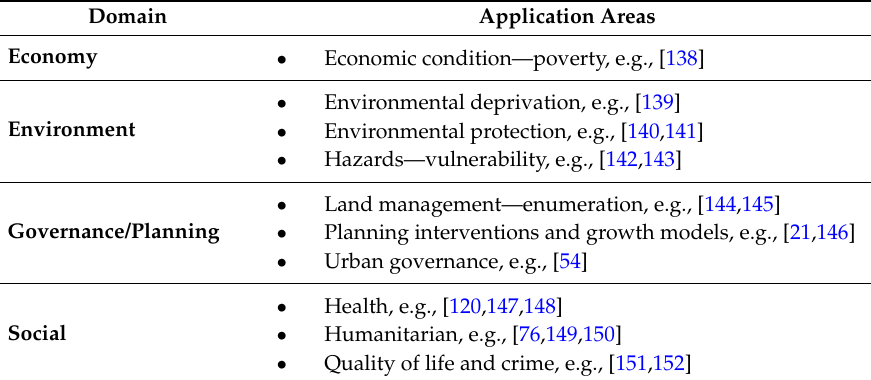
Table 3. Application domains of remote sensing-based information on the morphology and temporal dynamics of slums.